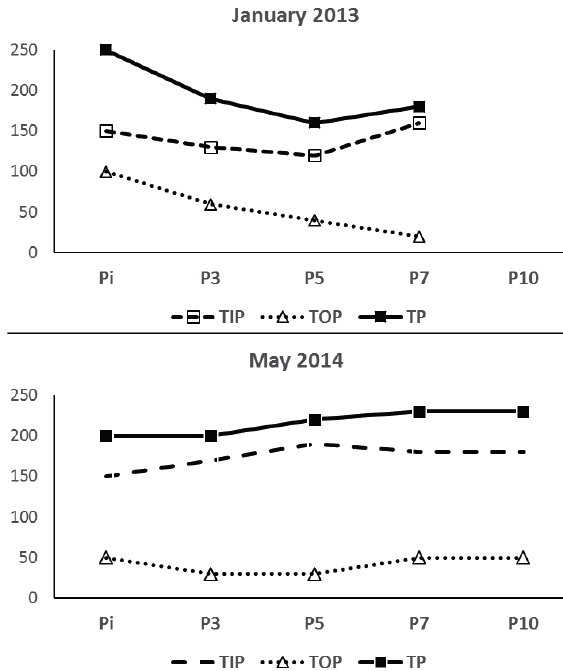
Figure 10 - Total (TP), organic (TOP) and inorganic (TIP) phosphorus (µg.g-1) distribution in bottom sediments of the Castanhão Reservoir. Station 1 most influence by upstream watershed; stations 7 and 10 at the dam area. Location of stations as in Figure